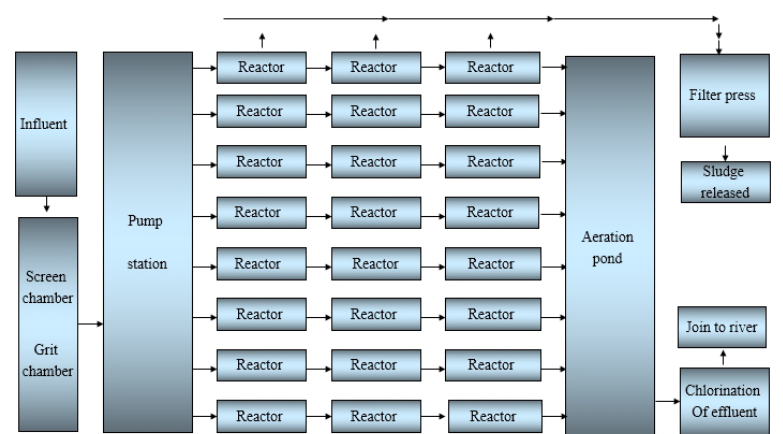
Fig. 3. WWTP in Hyderabad (This